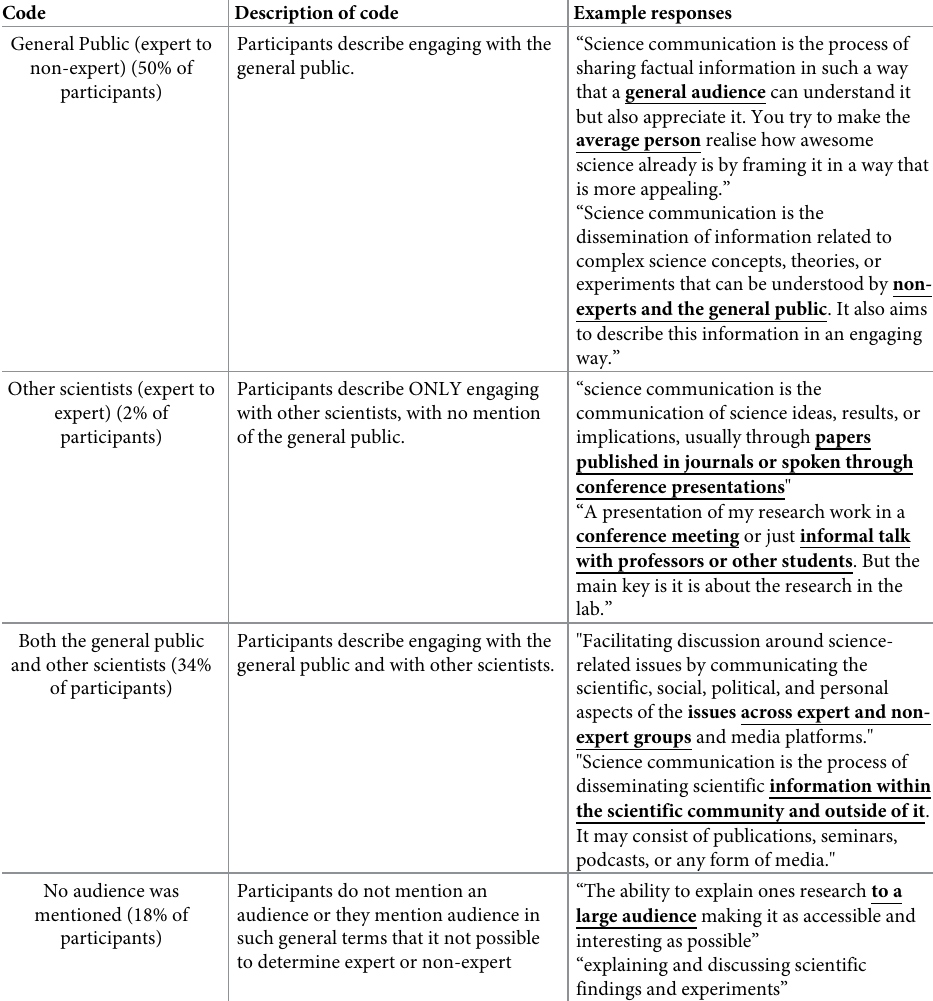
Table 2. Intended audiences STEM graduate students expect to engage